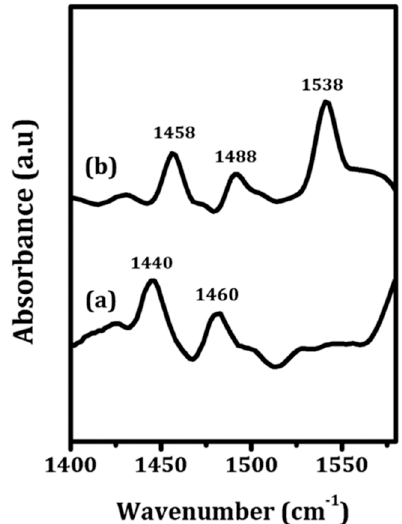
Figure 5. FTIR spectra of pyridine adsorbed on ( a ) ZrO 2 and ( b ) 5W-Zr. The samples were pretreated with helium at 373 K before pyridine was adsorbed onto the samples at room temperature.